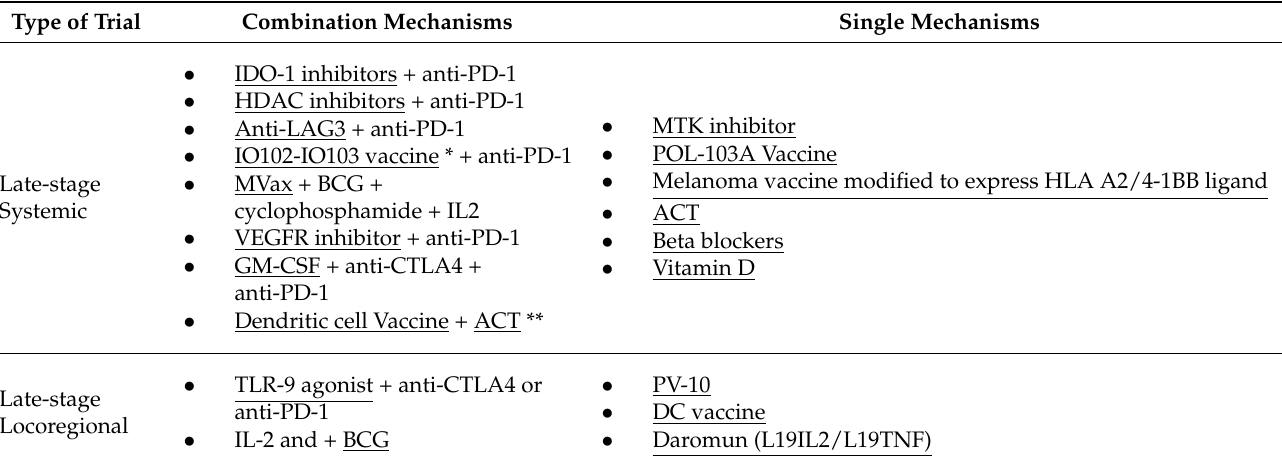
Table 1. Exploratory drug therapy mechanisms in combination or monotherapy